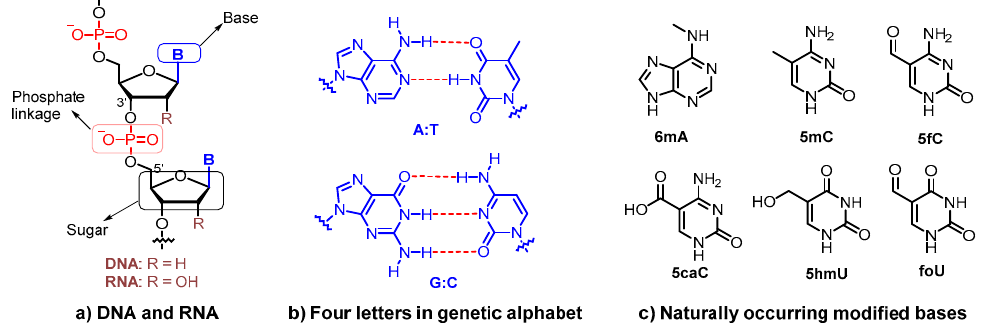
Figure 1. Structures of genetic materials. ( a ) Structures of DNA and RNA containing sugar, base, and phosphate moieties; ( b ) Watson–Crick base pairs formed by A:T, and G:C in DNA; ( c ) Examples of modified bases observed in nature.